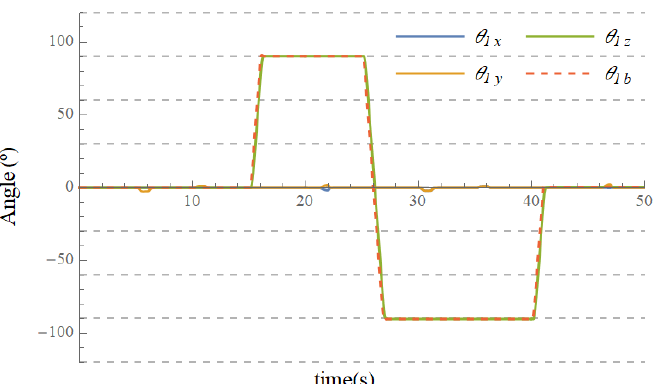
Figure 10. Evolution of Rotation Vector 1 when testing the link model using only encoder measurements.